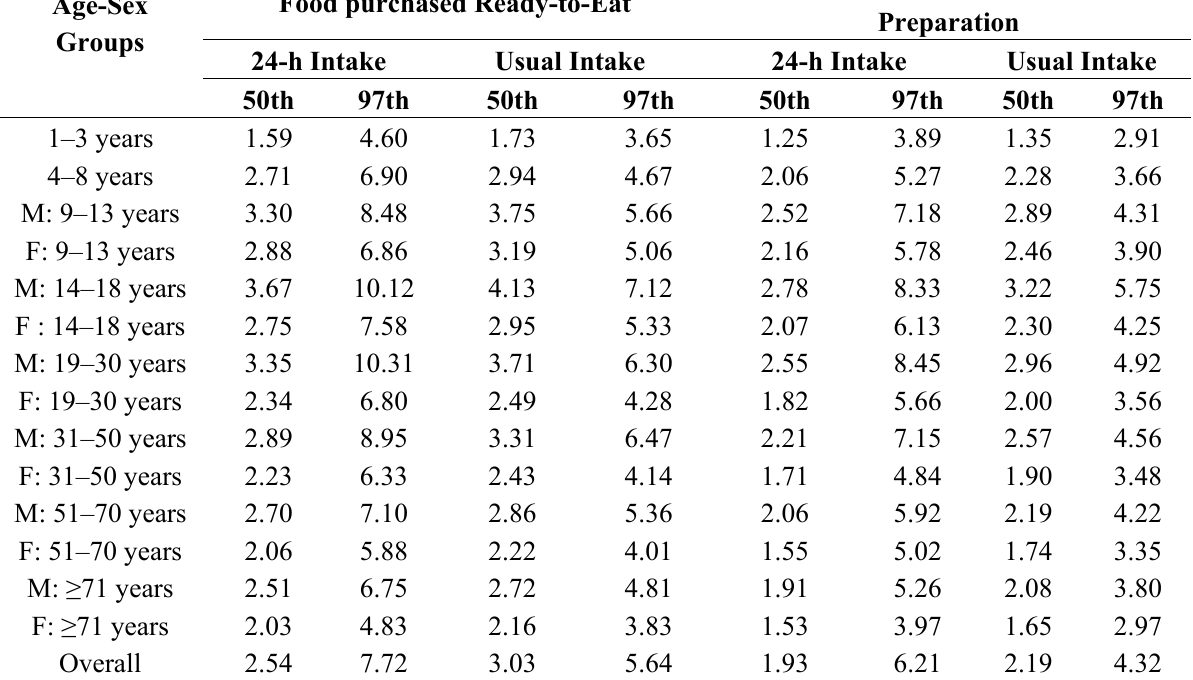
Table 5. Estimated percentiles of gluten exposure (mg/day) in different age-sex groups assuming hypothetical levels of gluten contamination of 20